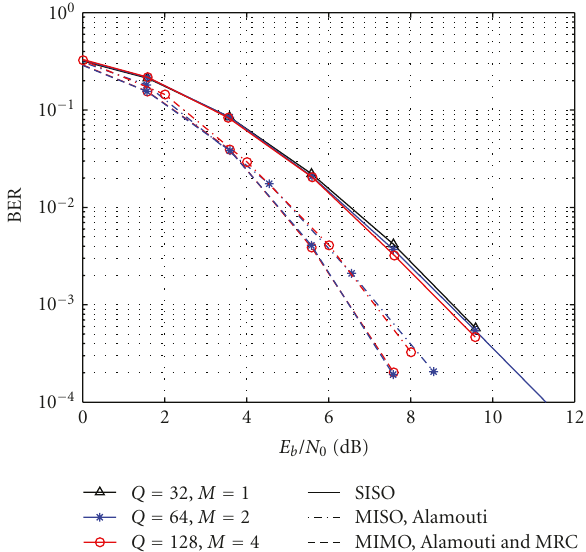
Figure 6: Coded performance for B-IFDMA with the same number of L = 32 blocks per user and with normalized antenna